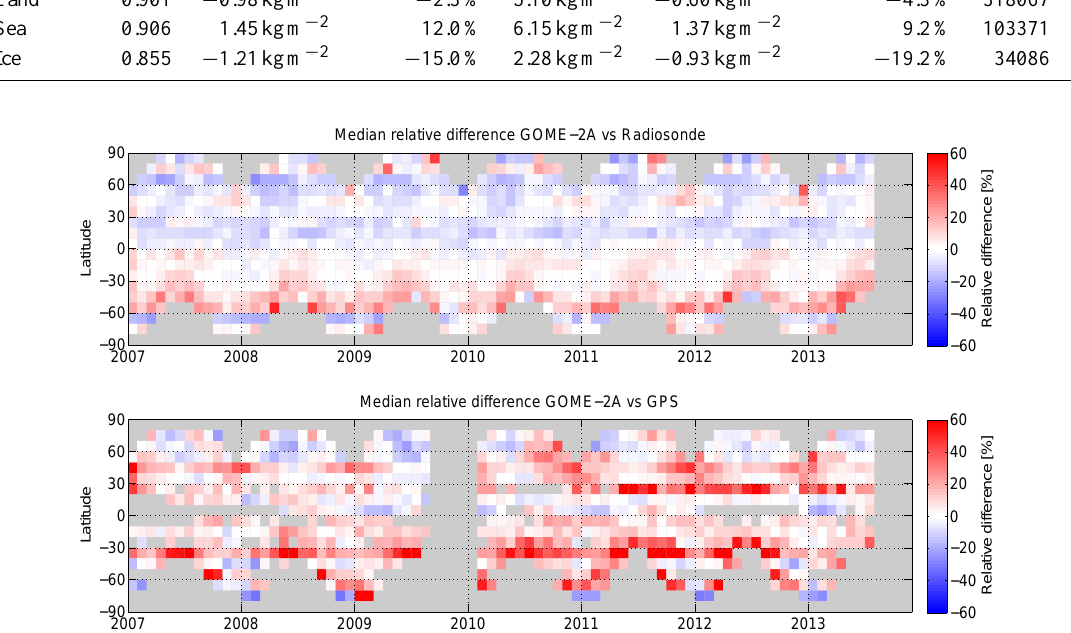
Figure 7. Monthly median relative difference (%) as a function of time and latitude, GOME-2A vs. radiosonde (top) and GPS (bottom). Each coloured box shows the median relative difference for one month in 10 ◦ latitude zone. Month–latitude bins with fewer than 10 co-locations are not